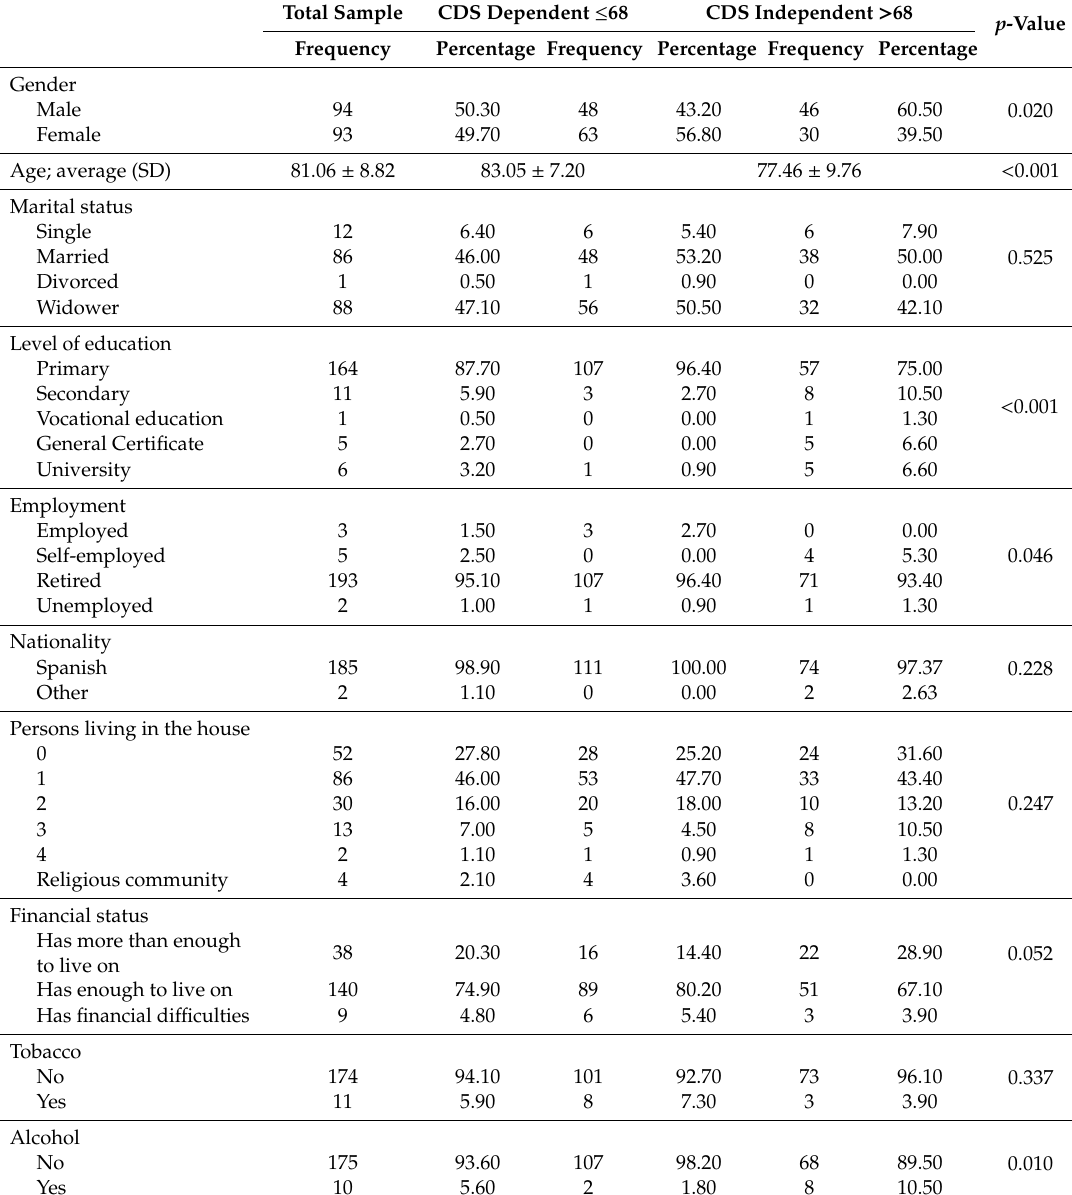
Table 4. Sociodemographic characteristics.